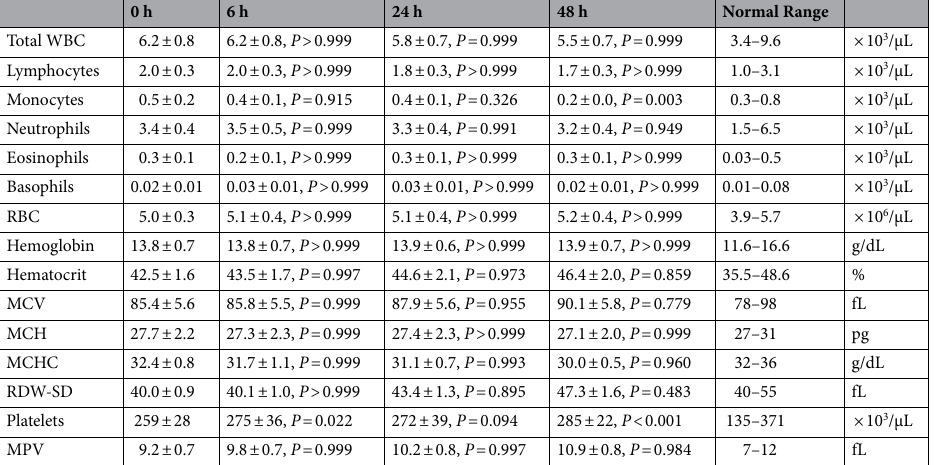
Table 1. Complete blood count and differential. Subjects were 8 healthy adults of both biological sexes between the ages of 25 and 52. Values are shown as the mean ± 95% confidence interval. Significance is Dunnett’s pairwise comparison to the 0 h values. WBC = white blood cells; RBC = red blood cells; MCV = mean corpuscular volume; MCH = mean corpuscular hemoglobin; MCHC = mean corpuscular hemoglobin concentration; RDW-SD = RBC distribution width size; MPV = mean platelet volume. Normal ranges are those established by the Mayo Clinic